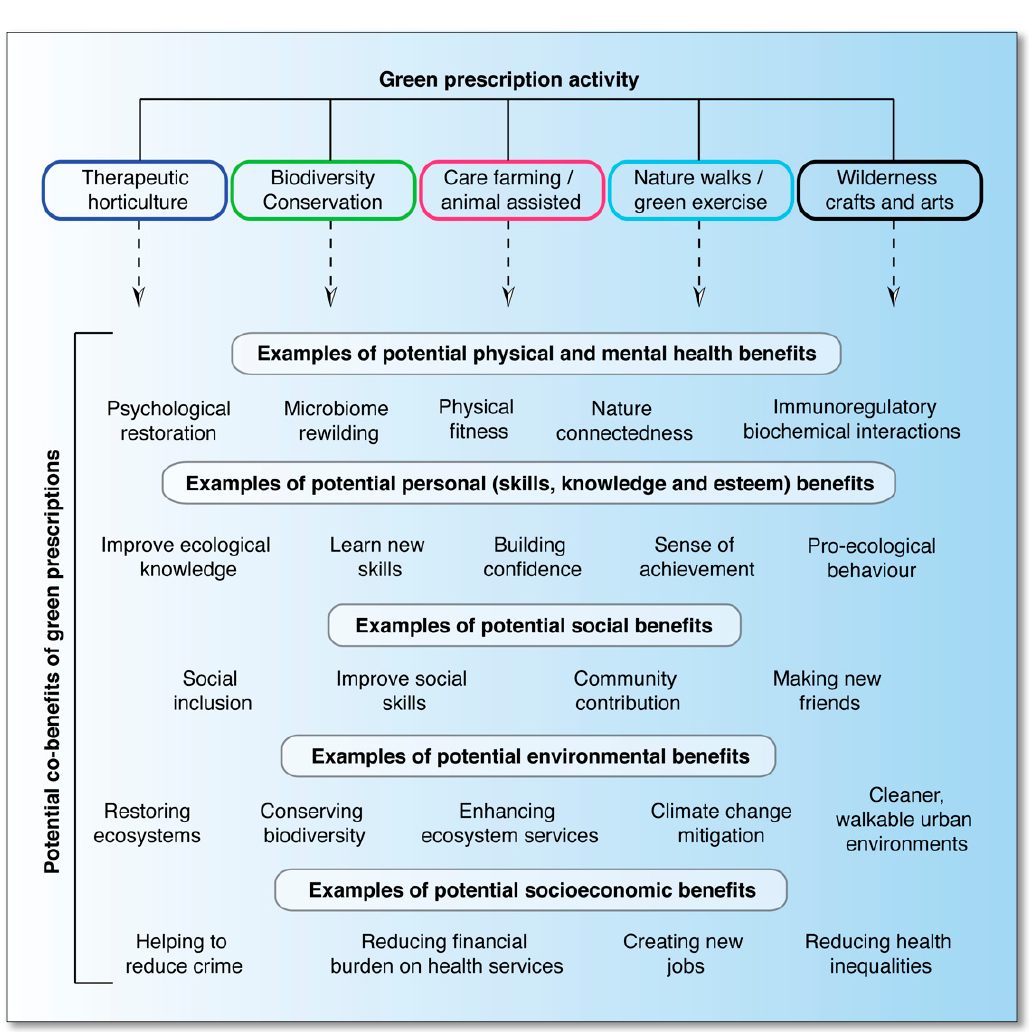
Figure 3. Potential green prescribing activities and co-benefits (created by the authors).